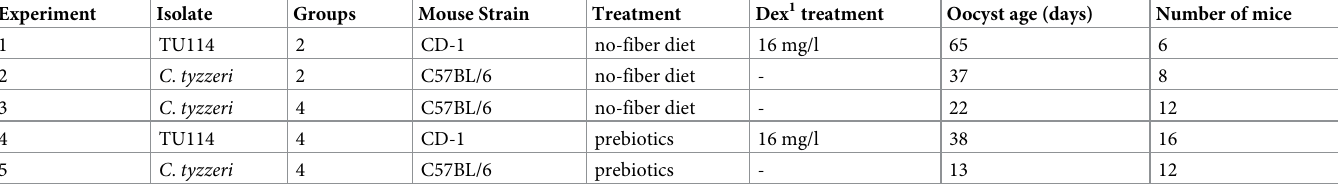
Table 1. Summary of